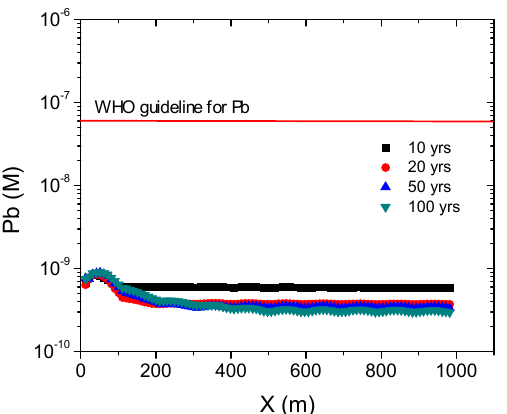
Figure 18. Contour map of total lead (Pb) concentration after 100 years of CO 2 leakage.